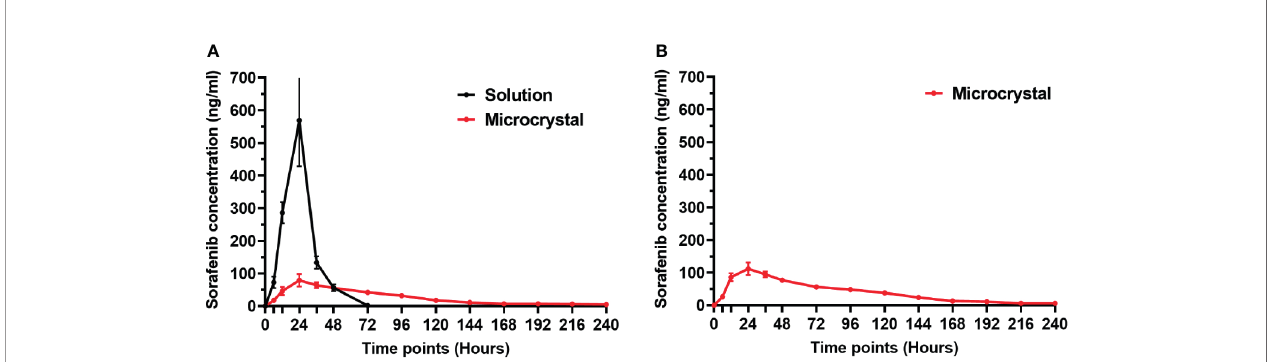
FIGURE 5 | The in vivo release of sorafenib from HCC tissues injected with sorafenib formulations. The in vivo release of sorafenib from HCC tissues injected with sorafenib formulations was measured by the concentration of sorafenib in the blood of nude mice (A) or immunode fi ciency rat (B) in Figures 2 and 3. At each time point, blood of animal was harvested and analyzed by the LC-MS/MS. The images are shown as the blood-concentration-curve of sorafenib. Solution refers to Sor- Sol and microcrystal refers to